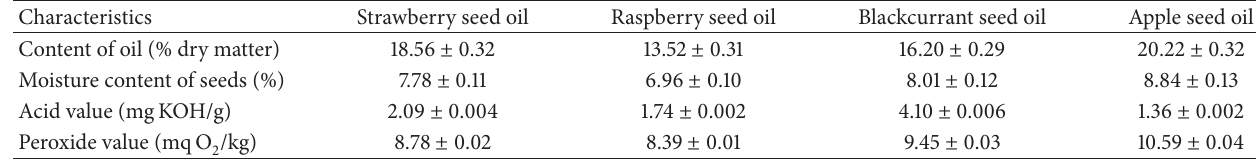
Table 1: Physicochemical properties of oils from strawberry, raspberry, blackcurrant, and apple seeds.